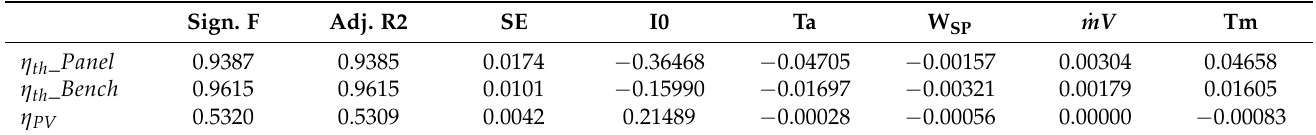
Table 4. Results of multiple linear regression analysis: Significance F (Sign. F), adjusted R square (Adj. R 2 ), and Standard error (SE) and linear coefficients of the independent variables. Sign.